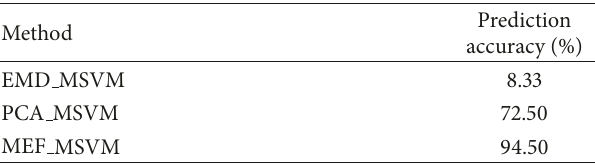
Table 8: Prediction accuracy of three different feature extraction